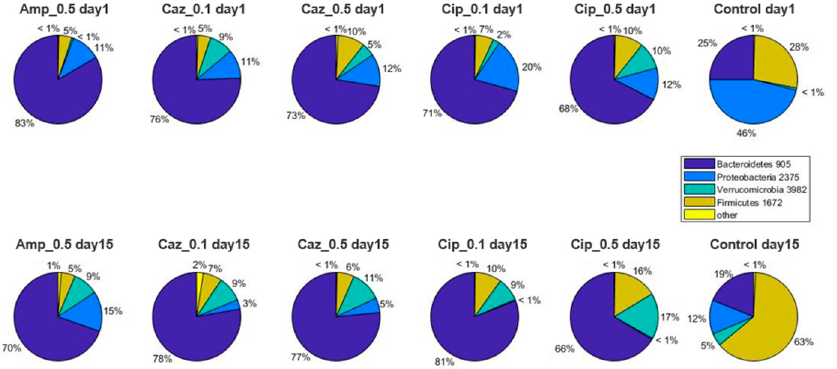
Figure 2. Phylum level abundances of bacteria. Average values of relative abundances at the phylum level were calculated for samples from the same treatment groups at both time points.